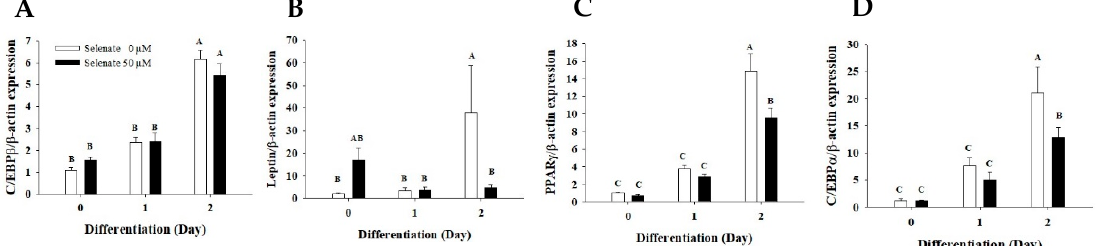
Figure 2. Selenate pretreatment suppresses the PPAR γ and C/EBP α gene expression during the early stage of differentiation. After 24 h pretreatment of one day post-confluent 3T3-L1 preadipocytes with 50 μ M selenate, the cells were differentiated. RNAs were collected at Day 0, 1, and 2 during adipogenesis. Quantitative RT-PCR was performed to estimate the mRNA expression of the adipogenic transcription factors, ( A ) C/EBP β , ( B ) PPAR γ , and ( C ) C/EBP α , and the adipogenic marker gene ( D ) leptin . The data represents mean ± standard error of mean (SEM). The experiment was conducted three times ( n = 12). Different characters indicate a significant difference at p < 0.05.